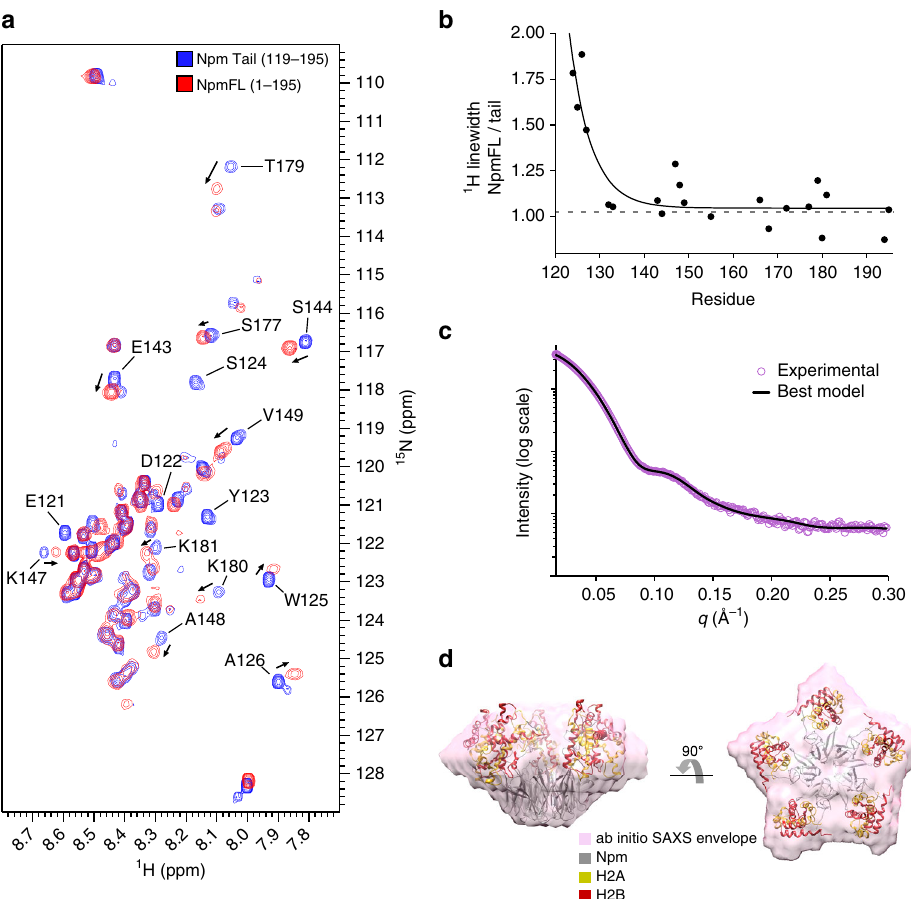
Fig. 6 Structural analysis of the pentameric Npm unbound and bound to H2A/H2B. a 1 H- 15 N HSQC of the full-length Npm (red) overlaid with the tail alone (blue) under the same buffer and temperature conditions. Residues with signi fi cant differences in chemical shift values or those broadened in the full- length protein are labeled. b Ratio of 1 H line widths of well-separated residues of the full-length protein compared to the tail domain alone. Ratio of 1 indicates peaks that are not broadened in the full-length spectrum. c SAXS curve (purple circles) of the core+A2:H2A/H2B complex. Top NMR-restrained SAXS hybrid model fi t to the scattering curve (black line). d SAXS ab initio envelope of the core+A2:H2A/H2B complex (purple). Top NMR-restrained SAXS hybrid model fi t into the envelope. Npm, H2A, and H2B colored gray, yellow, and red,